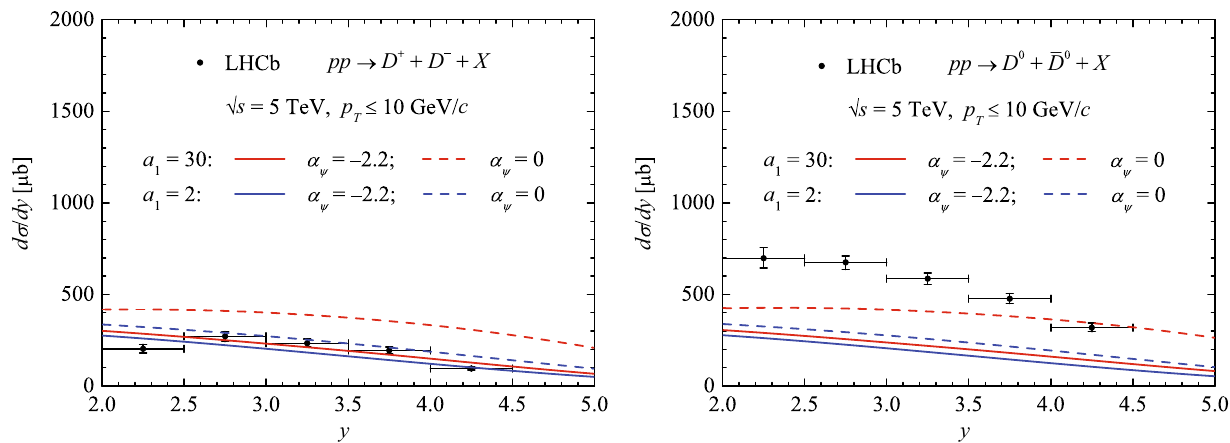
√ s = 5 TeV. Data are from the